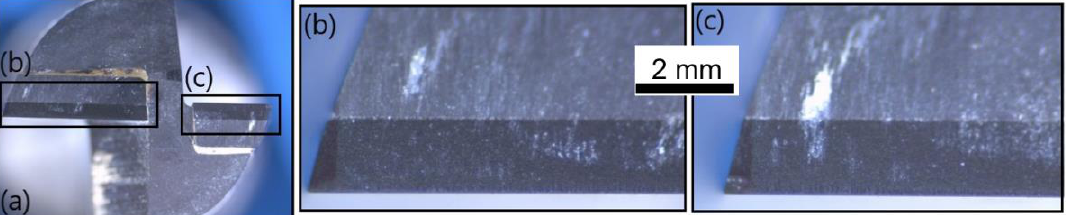
Figure 19. T3: Front view at the fresh state: ( a ) global view of the end-mill, ( b ) zoom on the clearance face of the first cutting edge and ( c ) zoom on the clearance face of the second cutting edge.